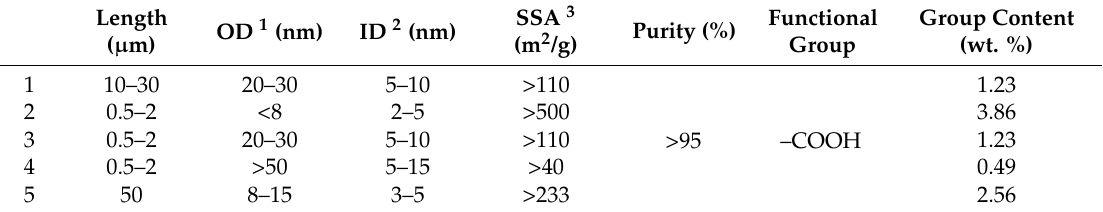
Table 1. Technical parameters of carbon nanotubes.